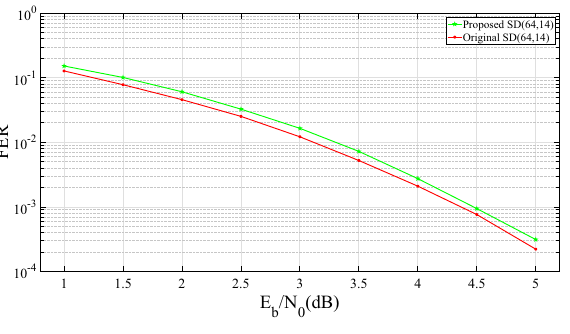
(b) The FER performance of the polar code P ( 64 , 12 )